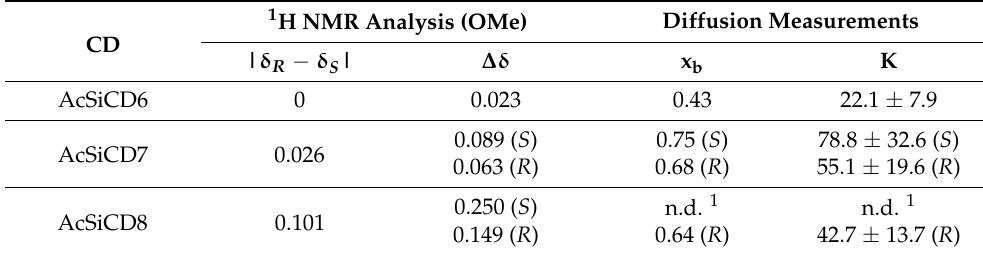
Figure 1. Expansions of 1 H NMR (600 MHz, C 6 D 12 , 25 ◦ C) spectra of ( R , S )-compound B (60 mM) alone (black) and in 1:1 mixture with AcSiCD6 (green), AcSiCD7 (blue), and AcSiCD8 (magenta), respectively. * indicates CD signals. Table 1. Equimolar mixtures of compound B (60 mM) with AcSiCD6, AcSiCD7, or AcSiCD8 (600